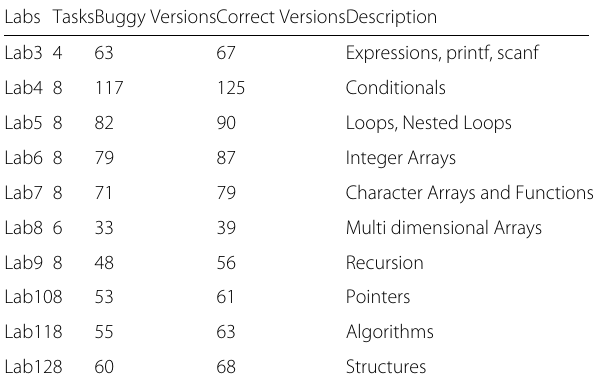
Table 1 Benchmark of programs to be clustered and